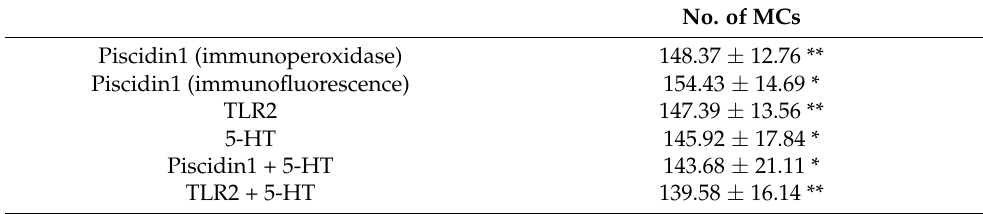
Table 1. Quantitative analysis results (mean values ± standard deviations; n = 3).